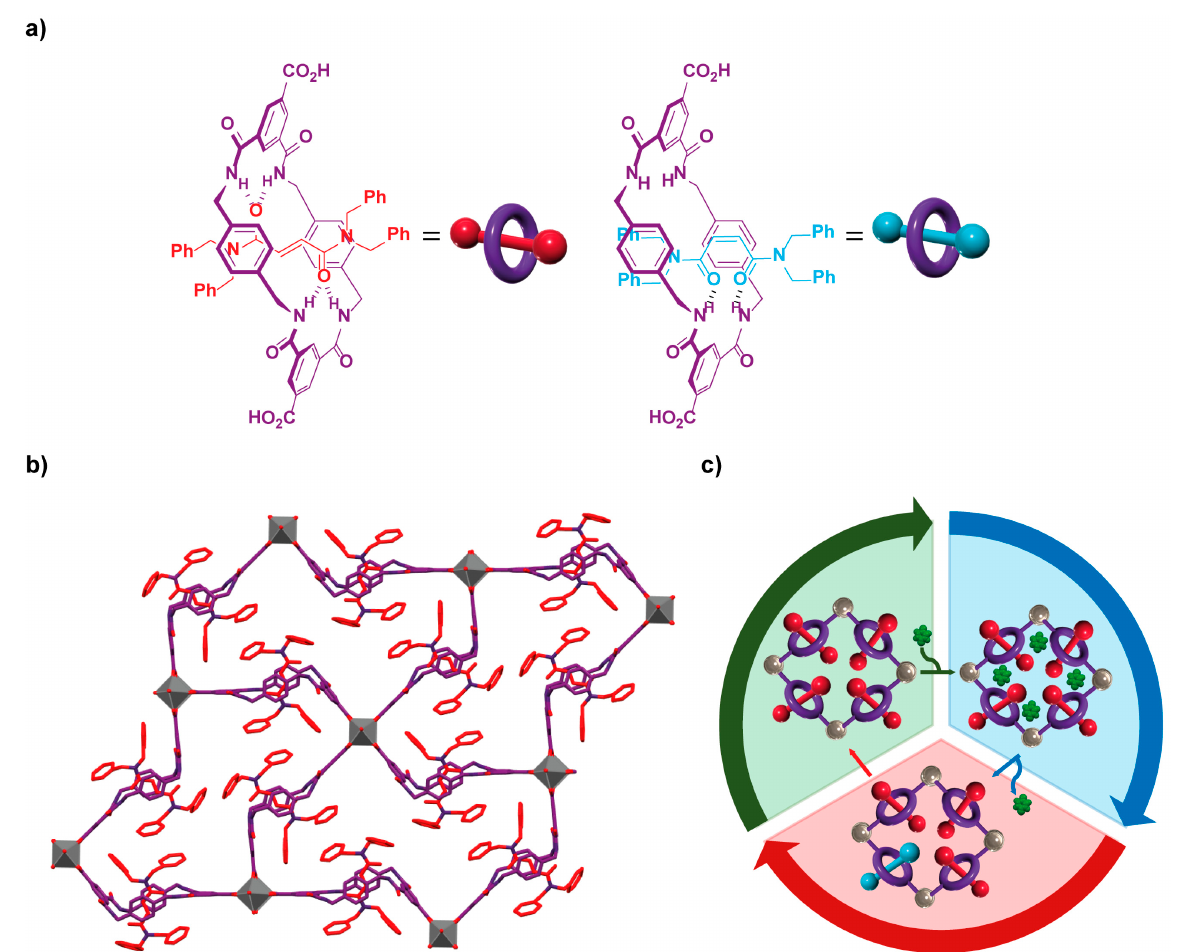
Figure 16. ( a ) Chemical structure of ligands ( E )-15 and ( Z )-15 ; ( b ) stick representation of the crystal structure of the two-dimensional UMUMOF-( E )-3 showing rhombohedral grids; ( c ) cartoon representation of the cyclic operation of UMUMOF-( E )-3 as molecular dispenser, involving quinone loading, photorelease and thermal treatment [113]. Color key: grey = copper atoms; purple = carbon atoms of the benzylic amide macrocycle and nitrogen atoms; red = carbon atoms of the fumaramide and oxygen atoms; green = p -benzoquinone molecules; purple toroid = benzylic amide macrocycle; red rod = fumaramide thread; blue rod = maleamide thread.